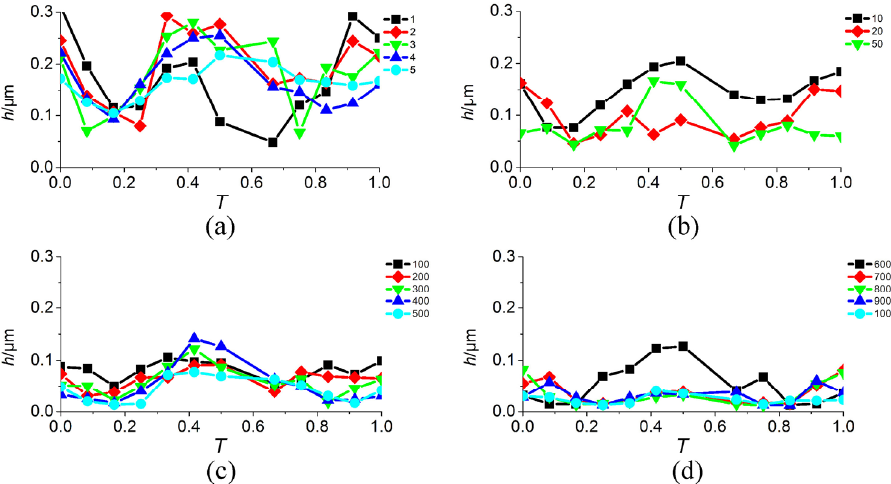
Fig. 8 Variation of central film thickness in some typical working periods ( v max = 0.01 m/s, w = 15 N, T = 0.5 s, L = 1.25